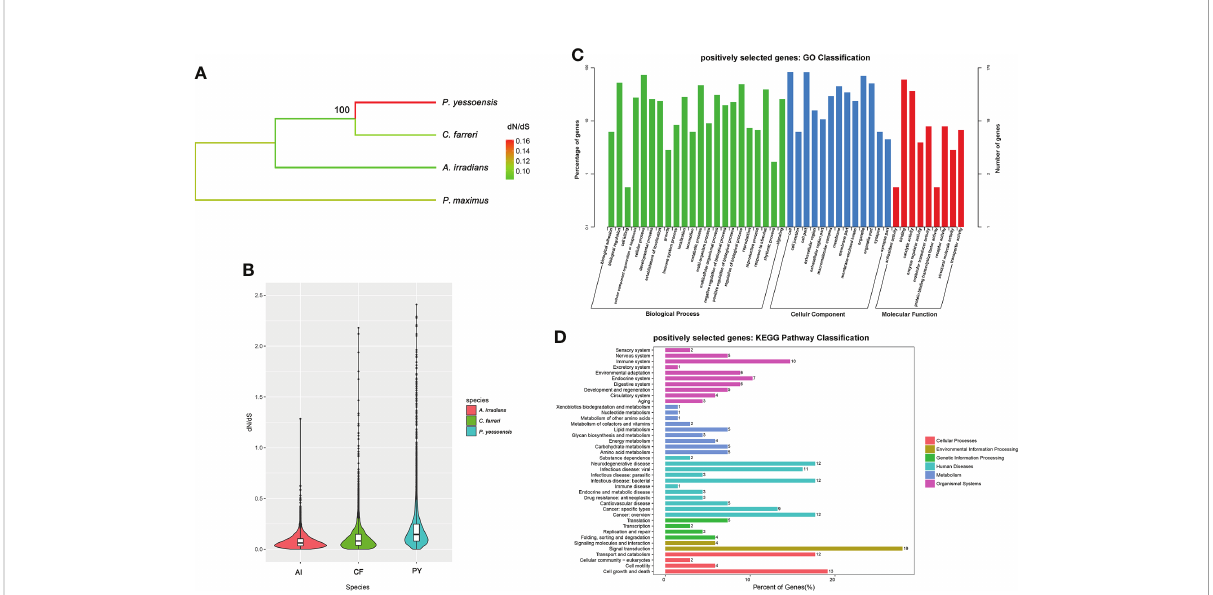
FIGURE 7 Comparative transcriptome analysis of different scallops. (A) Phylogenetic analysis of different scallop species with single-copy orthologs. The color of the branch indicates the dN/dS value of the ‘ super gene ’ connected by all orthologs of the species. (B) Distribution of dN/dS values in